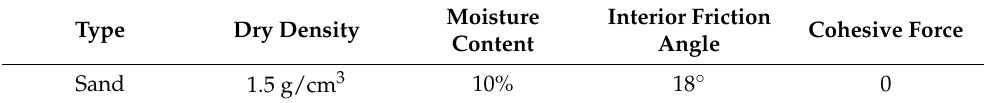
Table 1. The Gaussian fitting results for three energy levels.